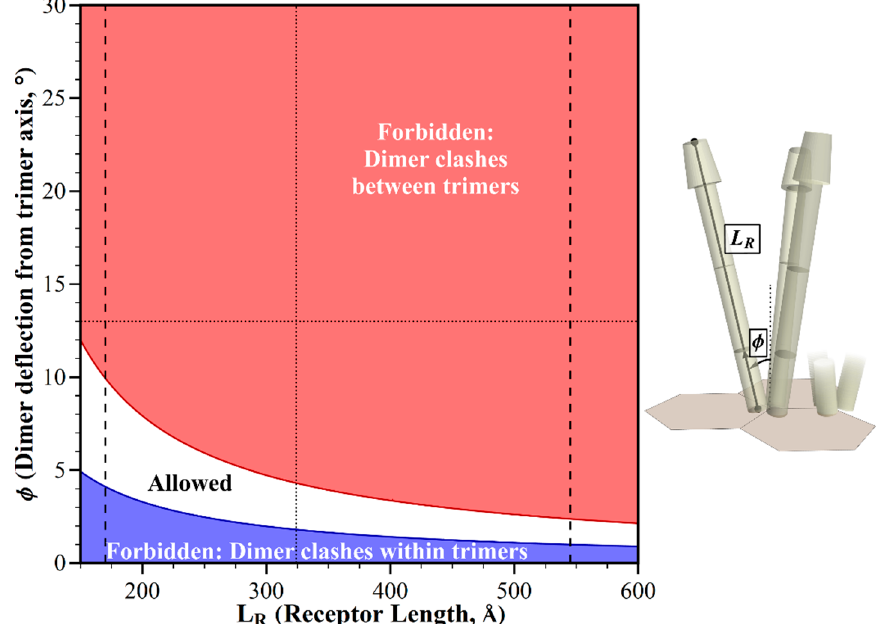
Figure 6. Geometric restrictions in core signaling complexes and their arrays as a function of dimer deflection, φ and receptor length, L R . The plot shows the structural consequences of combinations of dimer deflection relative to the trimer central axis and the receptor length. For any allowed combinations (white area), the receptors fit into the available space. For the forbidden combinations, they do not, because of the structural clashes between dimers in neighboring trimers (red areas), or in the same trimer (blue areas). Dashed lines show the postulated shortest and longest chemoreceptor length, as in Figure 3. Dotted lines show respective values for E. coli receptors.